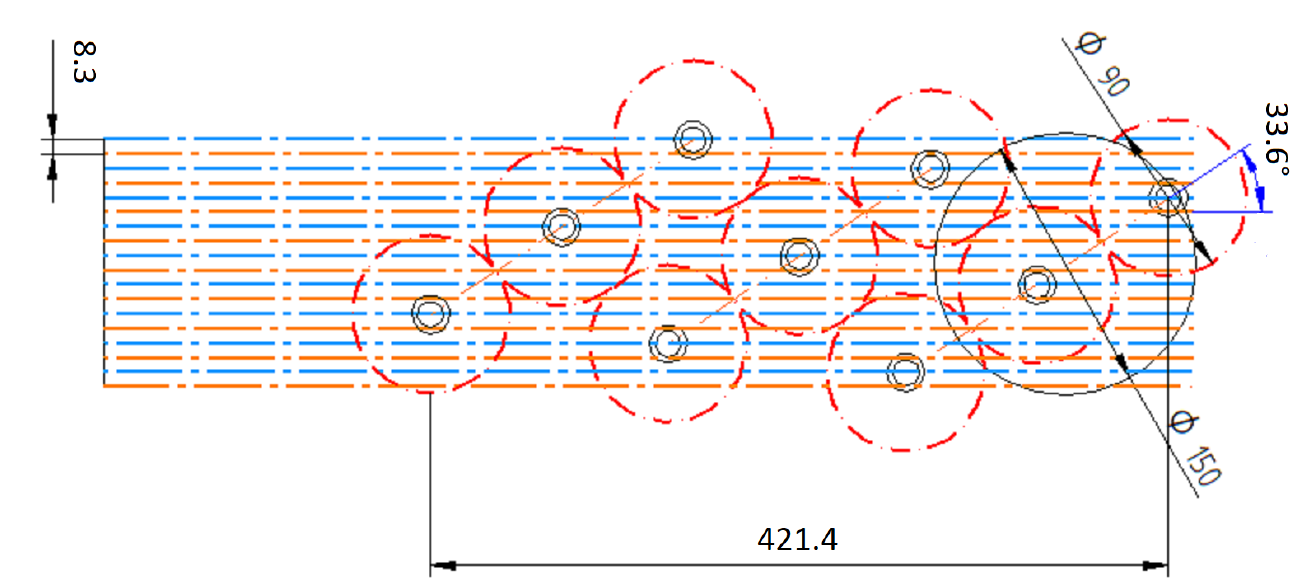
Figure 9. The traces of 9 PCPG-powered DBDs, each with width of 16.6 mm. The 6-inch wafer is treated in two sweeps with 8.3 mm offset: back and forth represented by blue and orange dot-dash-lines respectively. The black circles show the position of the coupling electrodes. The red dashed line circles visualize the minimum allowed tip-to-tip distance between the